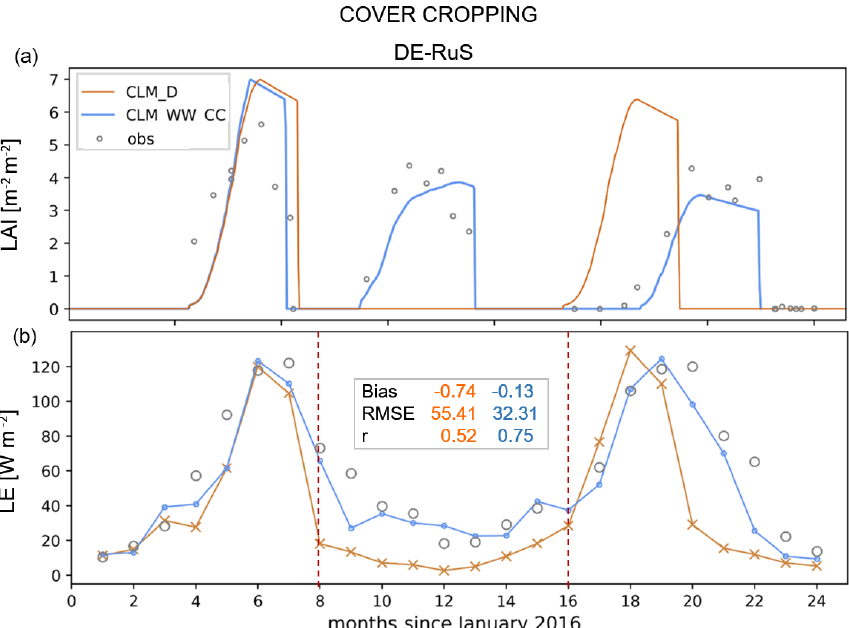
Figure 7. (a) Simulated LAI for cover cropping at DE-RuS with barley (2016), a greening mix cover crop (2016/2017), and sugar beet (2017) using the new cover-cropping subroutine (blue) in comparison to control simulation results with the default phenology algorithm of CLM5 (orange). (b) Corresponding monthly averaged simulation results for the latent heat flux with respective bias, RMSE, and r for the time window are shown between the dashed red lines (calculated using simulation output and observation data at daily time step). Available observation data are plotted in grey.